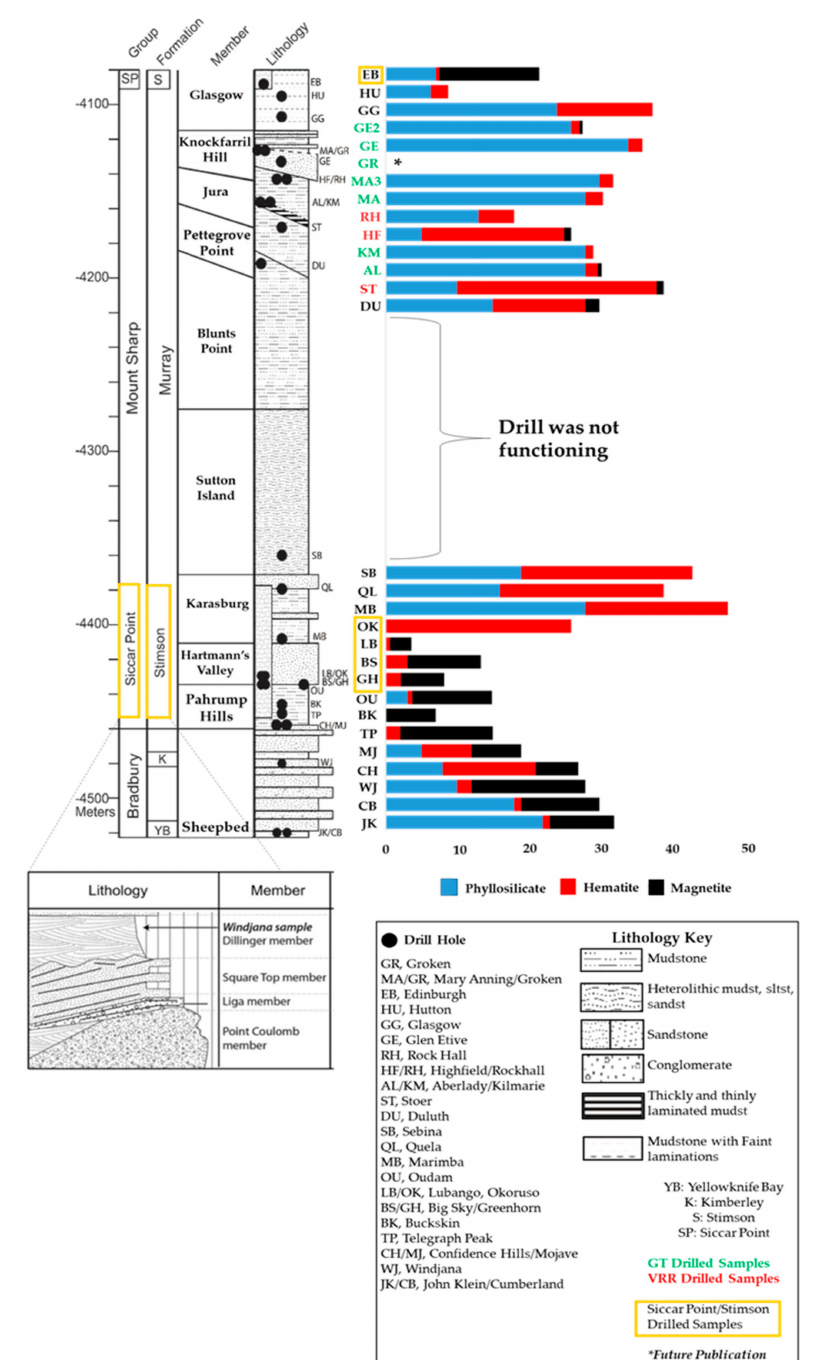
Figure 5. Stratigraphic column of the sedimentary rocks at Gale crater from the MSL sedimentary and stratigraphy working group. The stratigraphic column reflects the units and formations investigated by Curiosity from the landing site near Yellowknife Bay through the Murray formation, Glasgow member. Modified enlarged inset of the Kimberley formation, showing the location of the WJ sample drilled in the Dillinger member [54]. Next to the column are phyllosilicate abundances of each of the drilled samples (blue bars), hematite (red bars), and magnetite (black bars) and Glen Torridon, Vera Rubin Ridge, and Siccar Point group samples are denoted, in addition to the drilling hiatus. * Sample GR mineral abundances are currently being assessed by the CheMin team and will be released in an upcoming